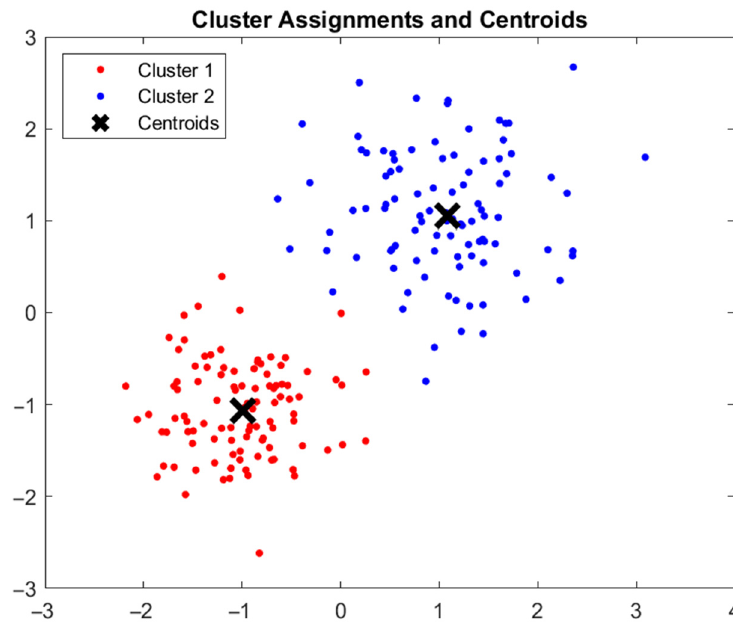
Figure 6. Example of a k-clusters clustering problem.